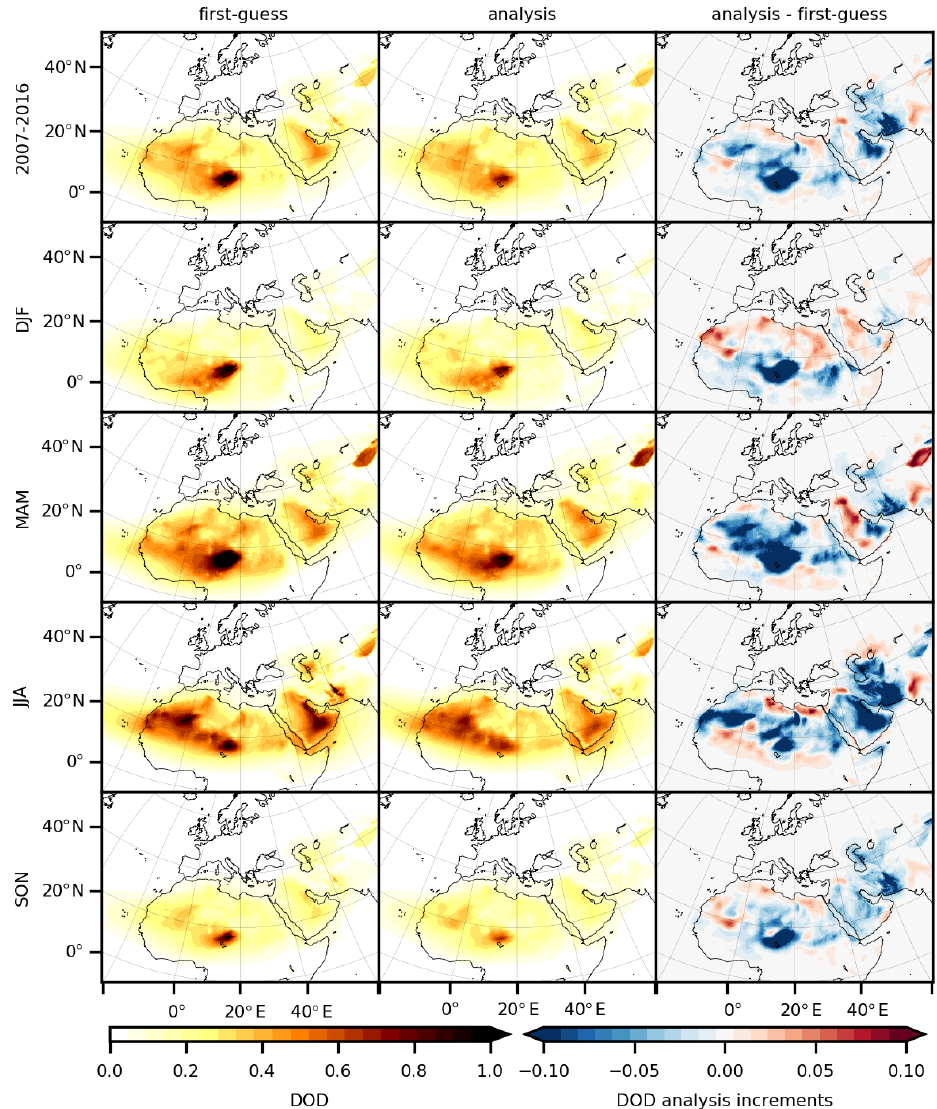
Figure 6. Maps of mean 3-hourly DOD first guess (first column), analysis (second column) and analysis increments (third column) calculated for the whole period (2007–2016; top row) and for different seasons (DJF, MAM, JJA, SON; rows 2 to 5). Model fields are the ensemble